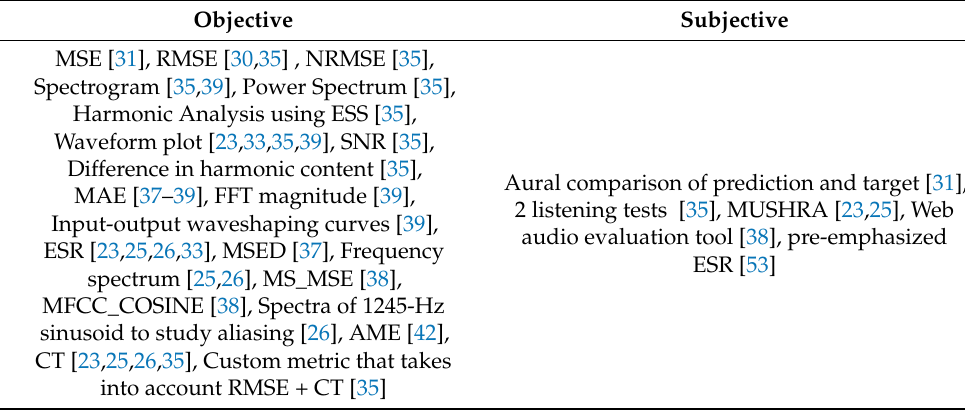
Table 6. Summary of the evaluation methods for network validation after